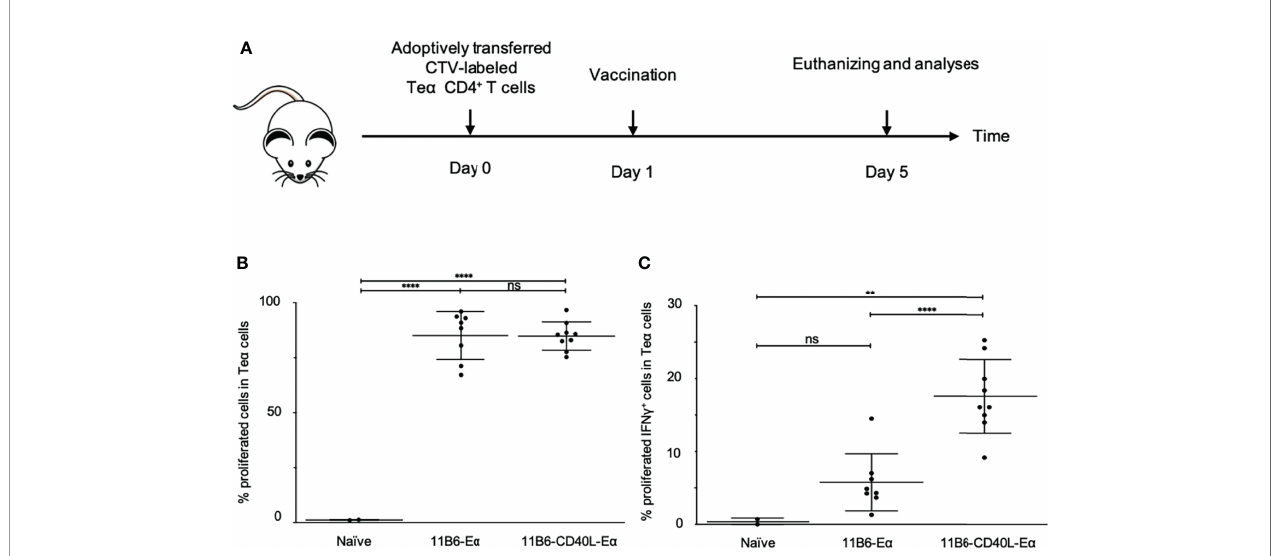
FIGURE 10 | Anti-CD40 11B6-CD40L-targeted E a antigen elicits superior proin fl ammatory cytokine production in E a -speci fi c CD4 + T cells in human CD40 transgenic mice. (A) Human CD40 homozygous transgenic mice were adoptively transferred i.v. with CTV-labeled E a CD4 + T cells and 1 day later, immunized with anti-CD40 11B6-Doc complexed with Cohesin-E a or anti-CD40 11B6-CD40L-Doc complexed with Cohesin-E a (1 m g). Four days later cells from the skin draining lymph node were examined by fl ow cytometry for proliferation (B) and activation (C) of the E a cells. To determine the activation status, some cells were stimulated with PMA/Ionomycin and then stained for intracellular IFN g . Each dot represents a separate mouse. Data from three independent experiments were pooled. ** and **** indicate statistically signi fi cant differences as de fi ned in Materials and Methods . ns indicates no signi fi cant